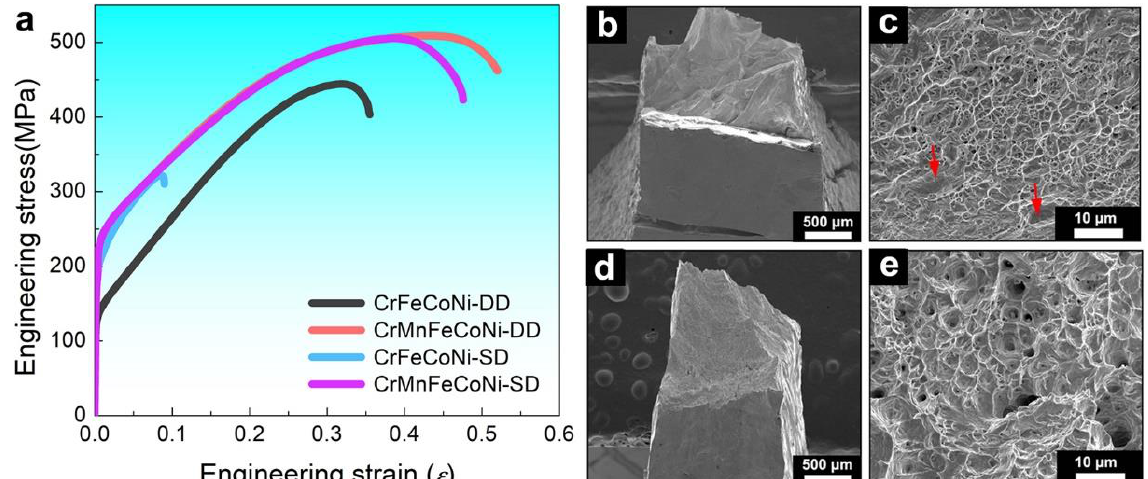
Figure 4. ( a ) The tensile curves of CoCrFeNi and CrMnFeCoNi along different direction; ( b – e ) the fracture surface of the CoCrFeNi ( b , c ) and CrMnFeCoNi ( d , e ) samples after tensile testing along the scanning direction. Table 2. The tensile mechanical properties of CoCrFeNi and CrMnFeCoNi samples. Yield Strength σ 0.2 Tensile Strength Materials Direction σ max (MPa) (MPa) CrFeCoNi DD 162 ±